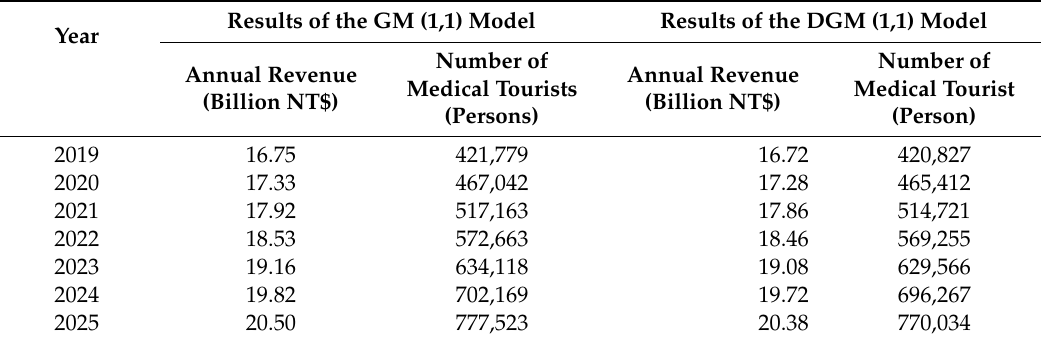
Table 6. Estimated values of Taiwan’s medical tourism industry in the next six